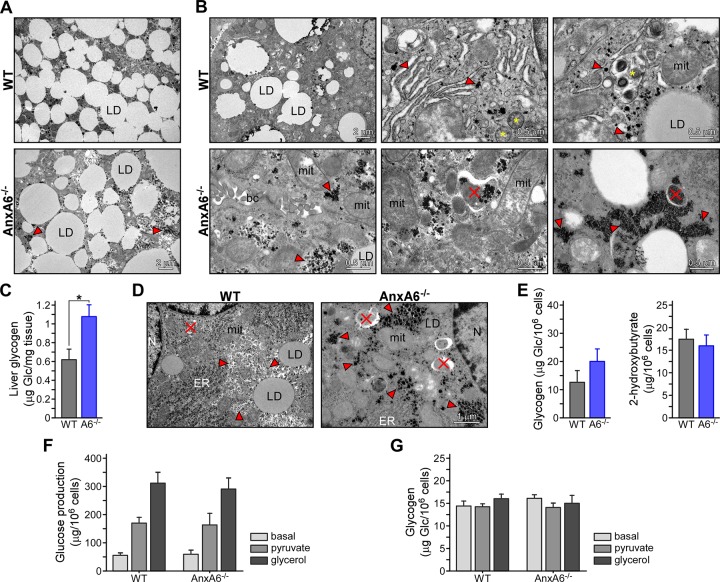
Lipid and glycogen accumulation in HFD-fed AnxA6-KO mice.(A-B, D) Liver tissue sections isolated from (A-B) HFD-fed and (D) chow-fed WT and AnxA6-KO (AnxA6-/-) mice were analyzed by electron microscopy. Representative images from 4 animals per group are shown. Bar is 0.5–2 μm as indicated. (A) HFD-fed AnxA6-KO mice show fewer, but larger lipid droplets. (B, D) Glycogen accumulation (red arrowheads) and glycogen autophagy (red cross) in HFD- and chow-fed AnxA6-KO mice. Bile canaliculi (BC), lipid droplet (LD), mitochondria (mit), endoplasmic reticulum (ER). (C) Glycogen content in livers from chow-fed WT and AnxA6-KO mice. (E) Primary hepatocytes from chow-fed WT and AnxA6 KO-mice were isolated and lysed to measure glycogen content. The media was collected to determine release of ketone bodies (2-hydoxybutyrate). (F-G) Primary hepatocytes from chow-fed WT and AnxA6 KO-mice were isolated, fasted for 6 h without glucose and then incubated with 2 mM pyruvate or 20 mM glycerol for 24 h as indicated. The media was collected and glucose secretion was determined. Cells were lysed and glycogen was extracted (see Methods for details; mean ± SEM; n = 3). * P <0.05 (Student’s T-test).